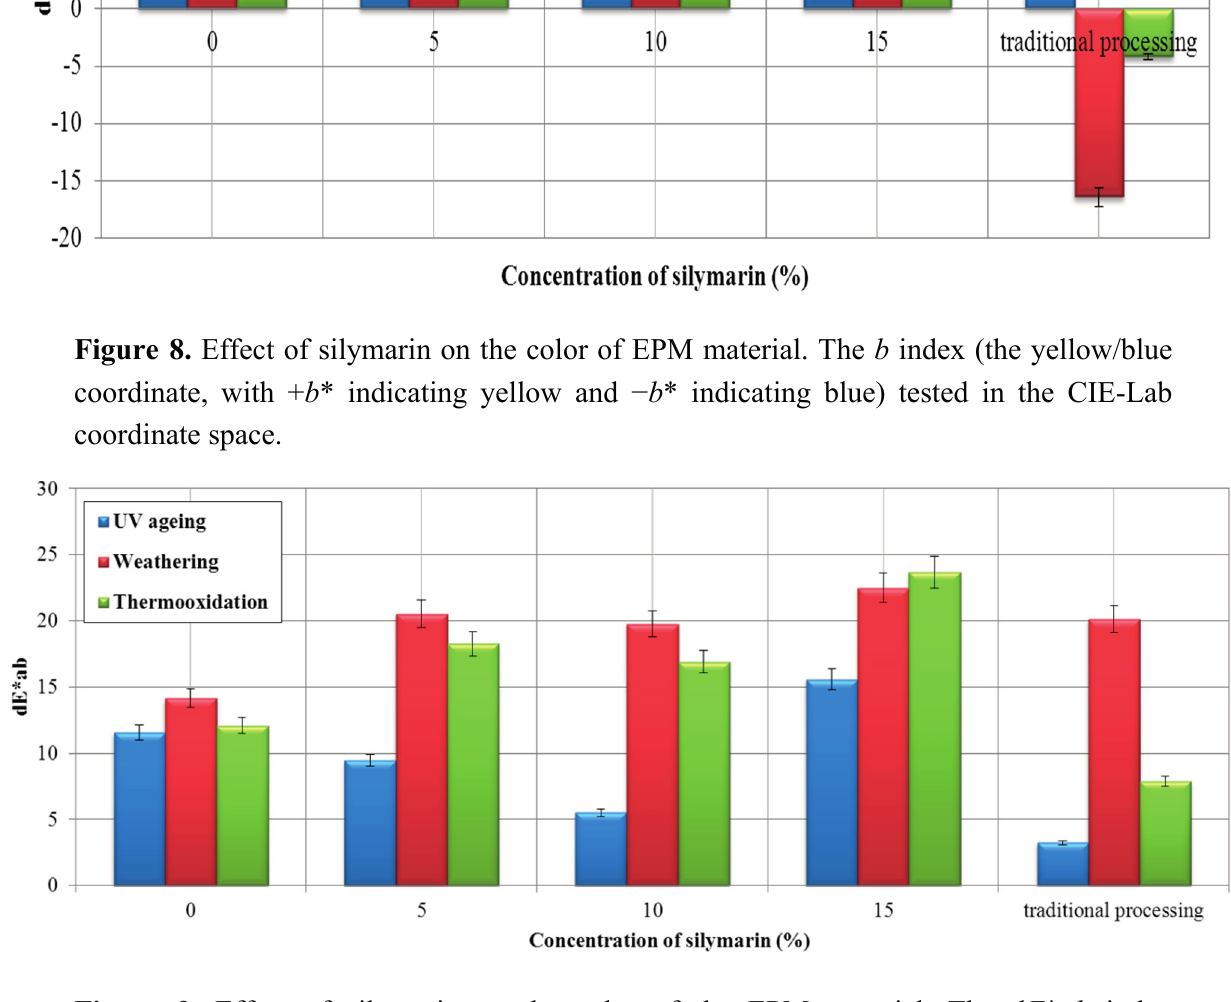
Figure 9. Effect of silymarin on the color of the EPM material. The d E * ab index ( Δ E * = ( Δ L * 2 + Δ a * 2 + Δ b * 2 ) 1/2 ) tested in the CIE-Lab coordinate space. Δ L * is the degree of lightness difference, Δ a * is the red/green difference, and Δ b * is the yellow/blue difference. The d E*ab parameter (Figure 9), indicating the degree of color change of the samples, shows that the greatest changes after weathering and thermooxidation occur for the sample impregnated with silymarin. Materials containing flavonoid undergo a color change due to the applied ageing factors, confirming that these natural substances can be used as color indicators of ageing time. Thus, these polymers can be used as packaging materials. Below is a graph of color change, d E*ab , as a function of the ageing time of the EPM rubber vulcanizate containing silymarin. The greatest recorded color change occurred under the influence of UVA radiation, with a maximum change after 25 days (Figure